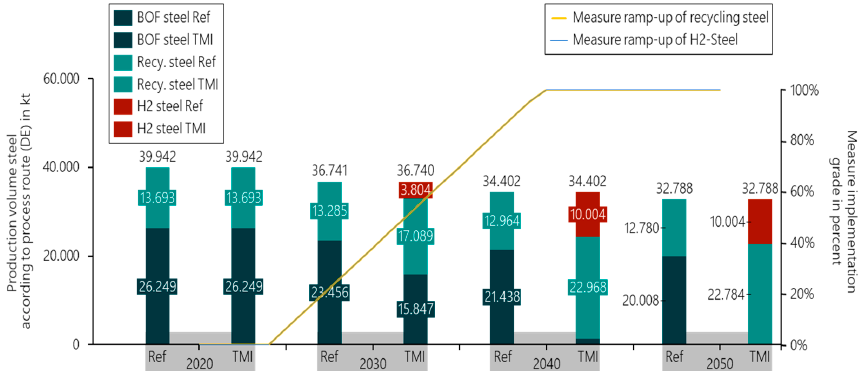
Figure 13. Production volume of steel production according to process route and start of production of process route changes in the steel industry, 2020–2050, BOF: Blast Oxygen Furnace. Total exogenous steel production in Germany decreases by 7 mill. t by 2050 [22,25]. Figure 13 illustrates that the ramp-up of the process route change in the TMI scenario begin between 2020 and 2030. In the TMI scenario, steel production is completely shifted to the secondary and H 2 -steel